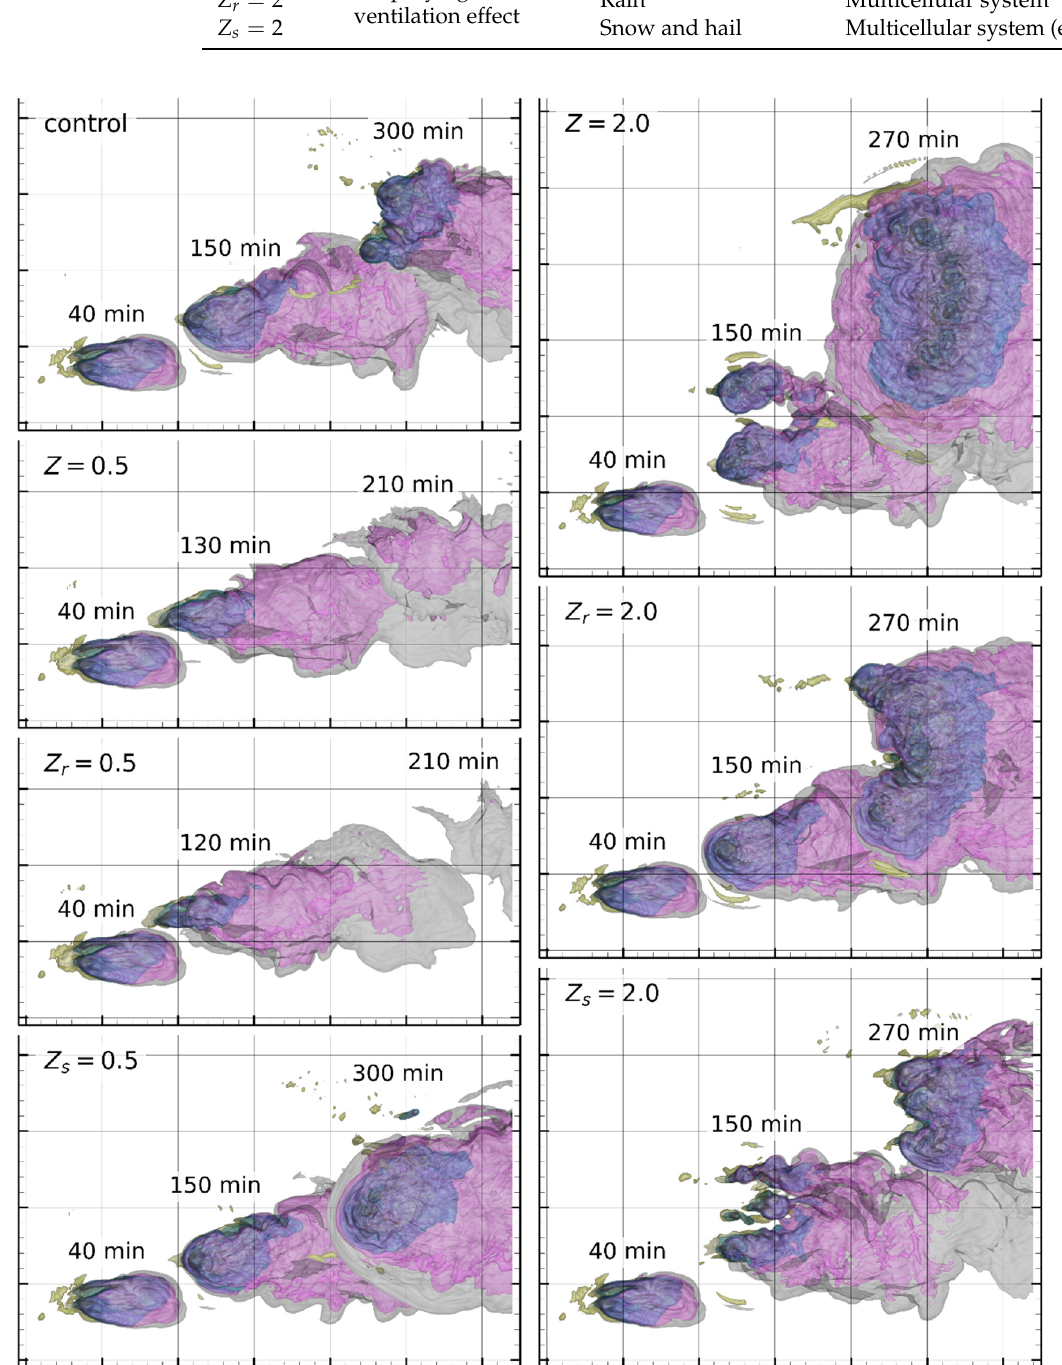
Figure 3 . Top view of the storms developed in various experiments. In each panel, the storm at three different time steps is overlapped, with the later one superimposed on the earlier one. The outer- most surface of the storm is represented by the 0.1 g/kg isosurface of the mixing ratio of total water condensates (gray). The 0.1 g/kg isosurfaces of rain (yellow), snow (purple), and hail (blue) are also shown. The full domain is 320 × 320 × 25 km 3 (with part in the north cropped off). The major (minor) grid spacing is 50 (10 km). The case (experiment) names are on the top-left corner of each panel, with timestamps to the north of the